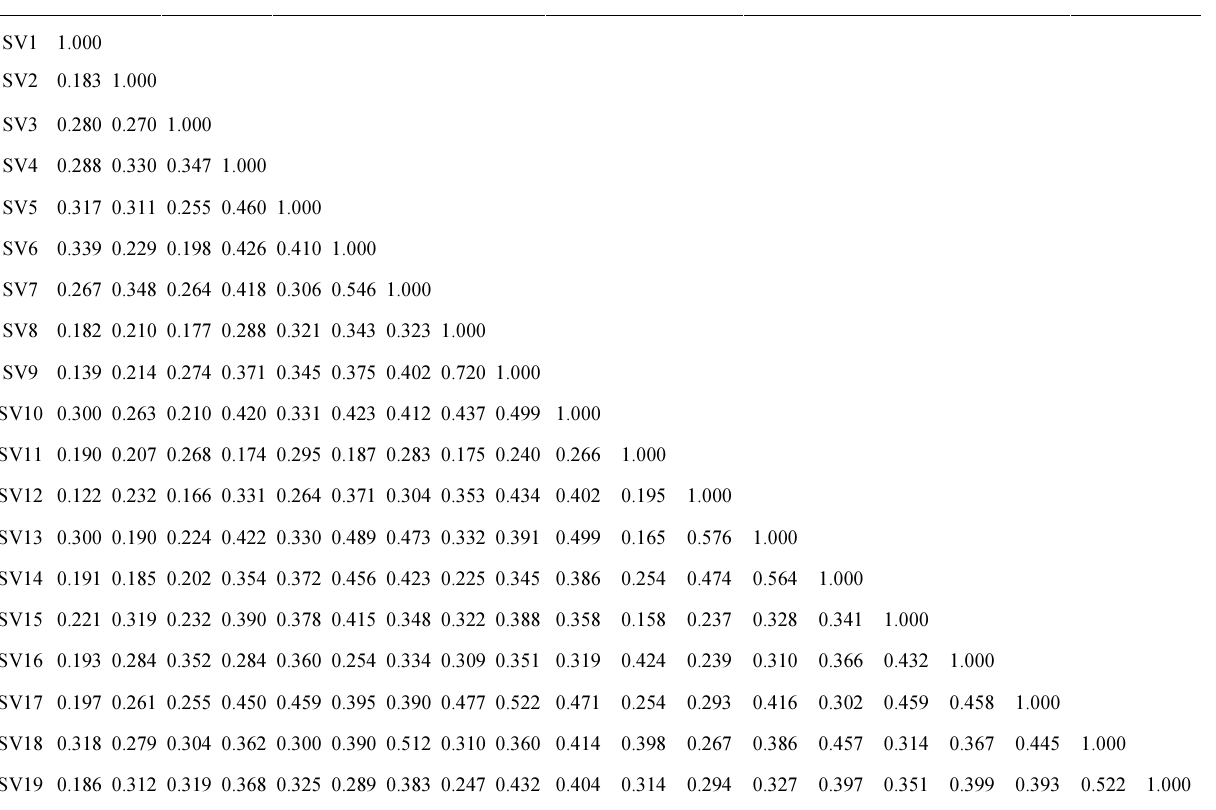
Table 4. Correlation matrix showing correlations among the SV for